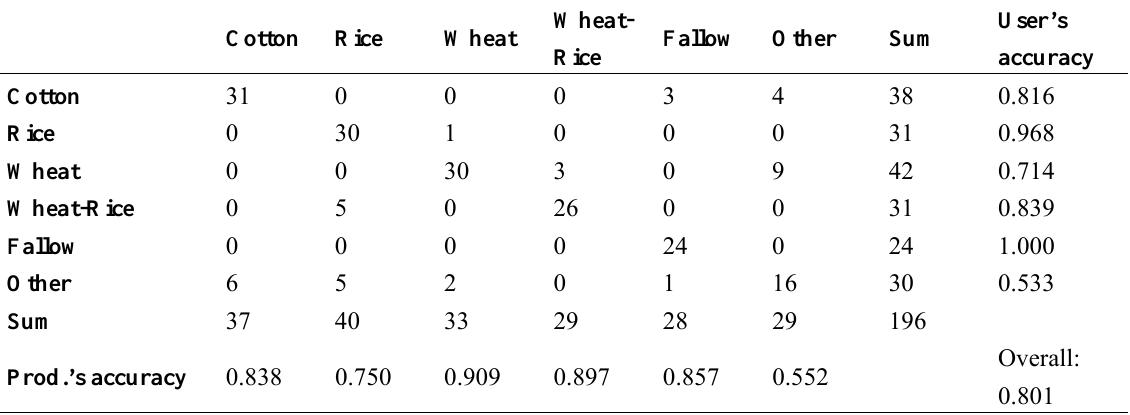
Table 5. Accuracy assessment of the crop distribution maps at object level: confusion matrix, user’s & producer’s accuracy and overall